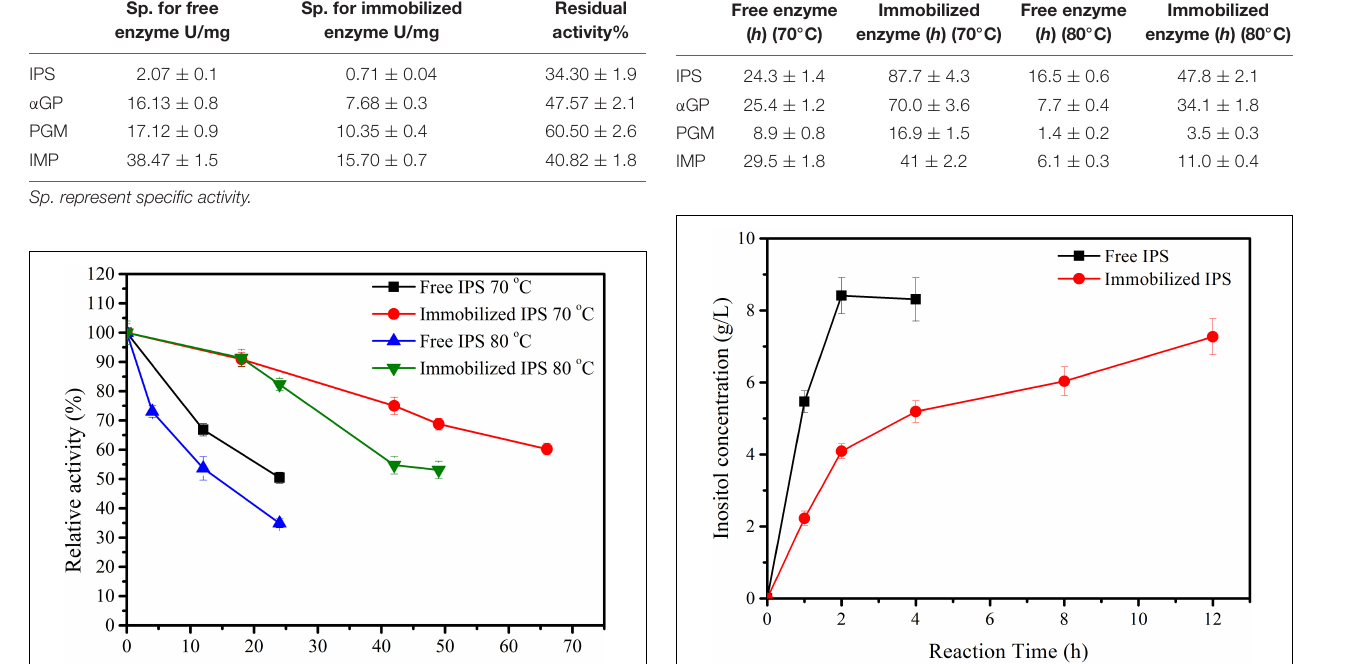
of immobilized IPS were 3.6 and 2.7 times higher than free IPS at 70 ◦ C and 80 ◦ C, respectively ( Table 2